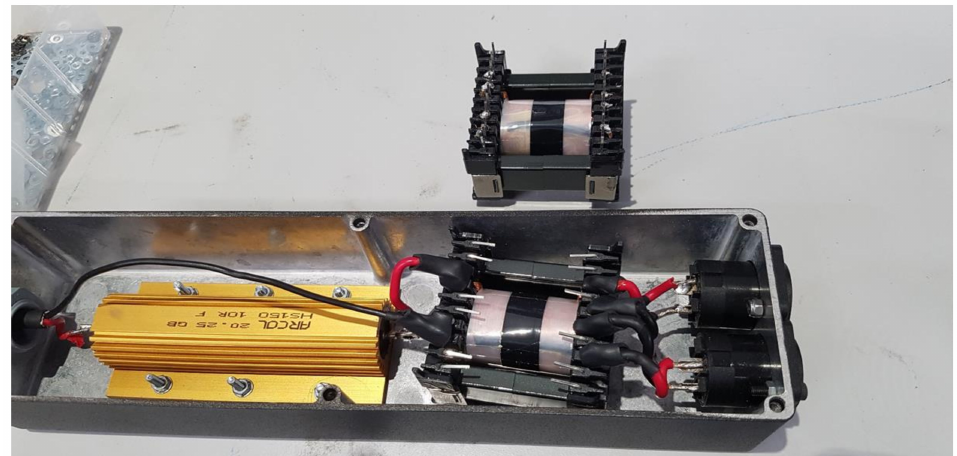
Figure 9. Step up 300 W transformer with isolation with 1 input channel to 2 output channels split.